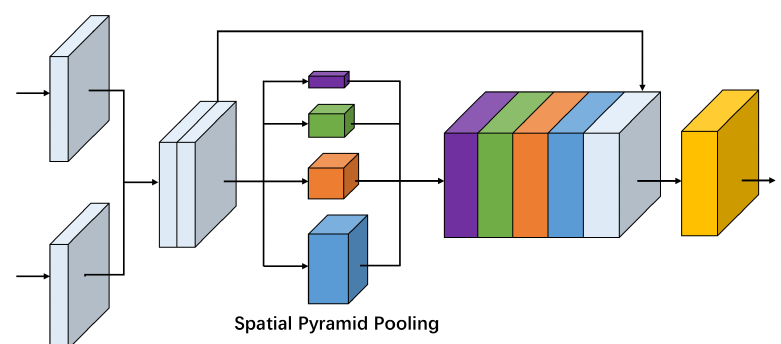
Figure 4. The proposed global perception fusion module based on spatial pyramid pooling. When the features from the two branches of the Siamese encoder are fused, four scale (1 × 1, 2 × 2, 3 × 3, 6 × 6) pooling operations follow. Then these feature maps are upsampled to the same spatial resolution and cascaded